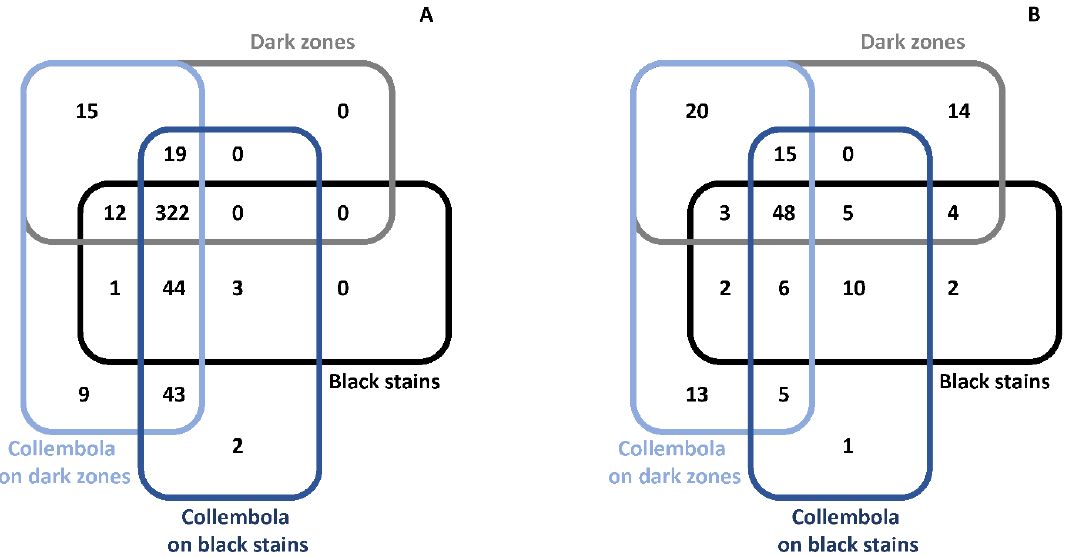
Figure 3. Venn diagrams showing unique and shared bacterial OTUs ( A ) and fungal OTUs ( B ) in collembola from dark zones, collembola from black stains, dark zones and black stains. Data used for black stains and black stain collembola are those from Alonso et al. [10].